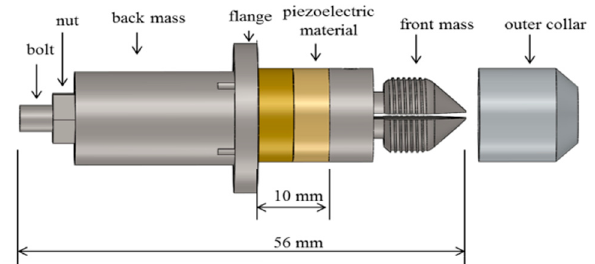
Figure 1. Schematic CAD (solidworks 2017, Dassault Systèmes SA) model of Langevin design needle actuation transducer.